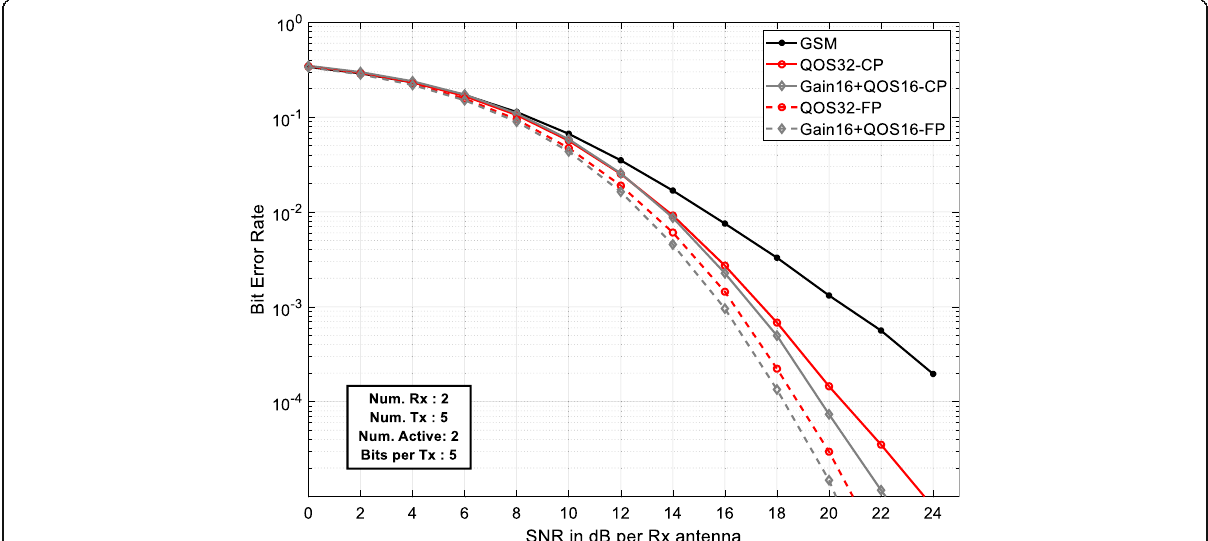
Fig. 7 BER performance comparison between the GSM-FP and GSM-CP systems with codebook precoding and fixed TAC-set at N t = 5, N a = 2, and N r = 2